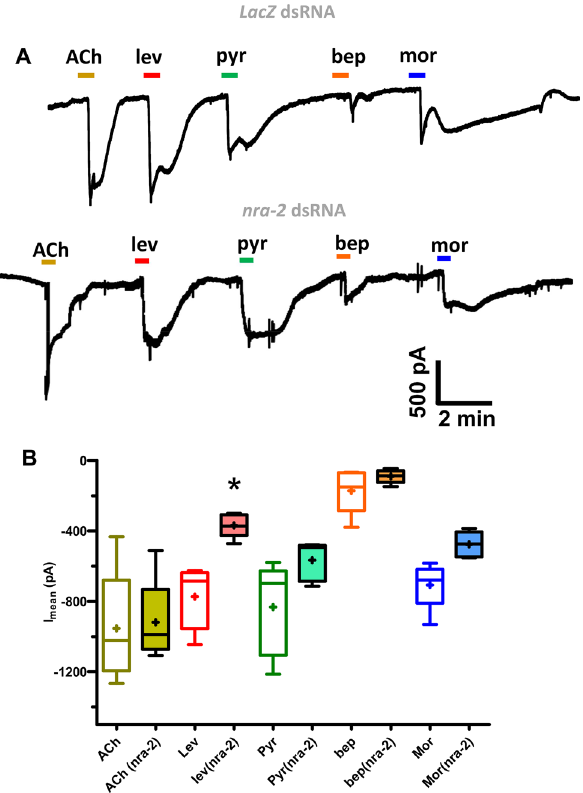
Figure 7. Whole-cell patch-clamp recording from muscle cells of the nra-2 dsRNA treated adult worms. ( A ) Representative whole-cell patch-clamp recordings demonstrating that adult worms soaked in LacZ dsRNA treated worms produced inward currents (30 µM ACh, pyrantel, bephenium and morantel, respectively) and the inward current response to levamisole and pyrantel were significantly reduced in nra-2 dsRNA treated worms. ( B ) Histogram demonstrating inward current response to (30 µM ACh, pyrantel, bephenium, and morantel) in LacZ and nra-2 dsRNA treated worms. The responses to levamisole and pyrantel were significantly reduced ( paired t- test, p < 0.005, n = 5 cells from 5